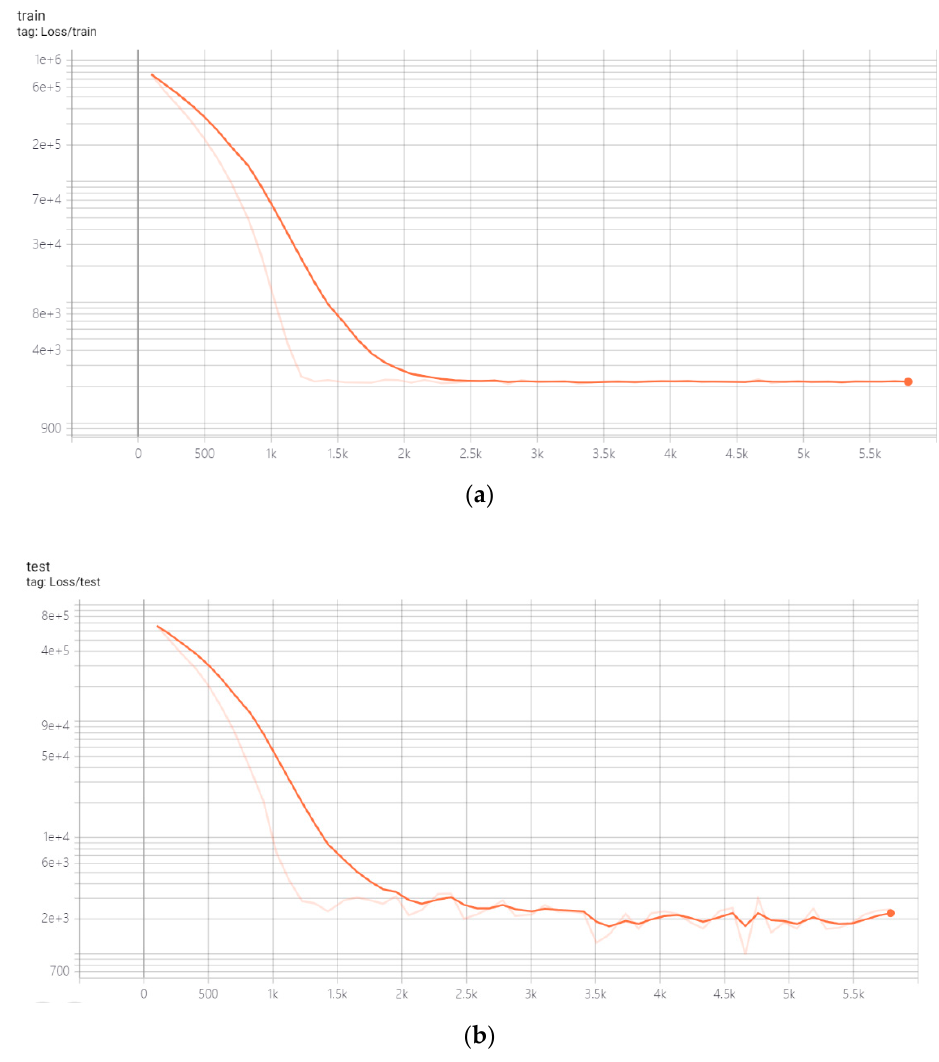
Figure 7. ( a ) The average square loss during training varies with the number of training sessions. ( b ) The average square loss during the test process varies with the number of training